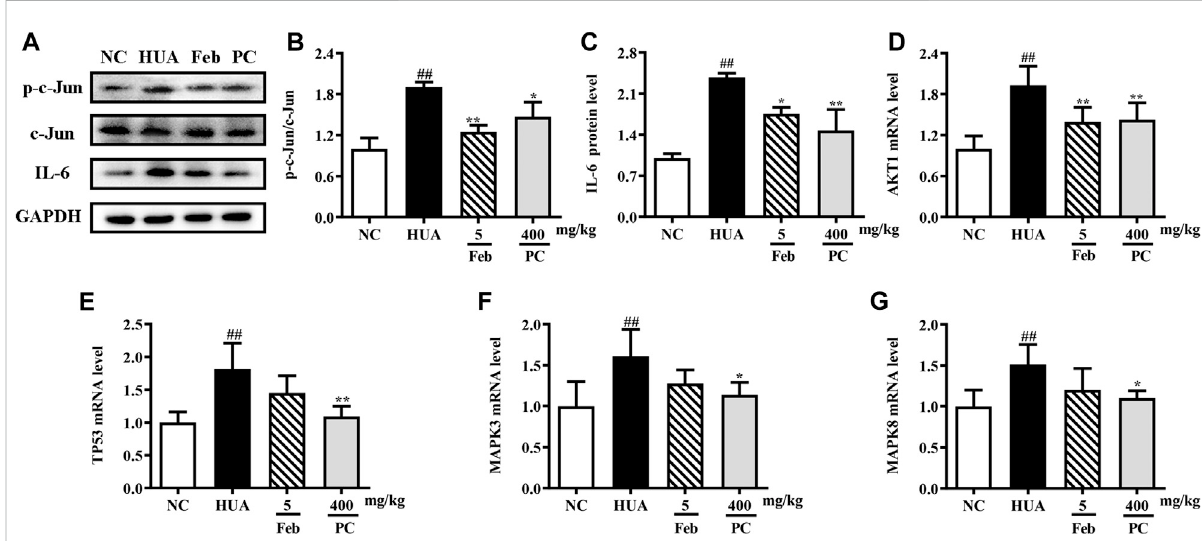
FIGURE 10 Effects of CP on the expression of hub genes. (A) Representative western blot bands. Relative protein expression levels of (B) p-c-Jun/c-Jun and (C) IL-6. Relative mRNA expression levels of (D) AKT1, (E) TP53, (F) MAPK3, and (G) MAPK8. The results are expressed as mean ± SD. ## p < 0.01, compared with NC group; * p < 0.05, ** p < 0.01, compared with HUA